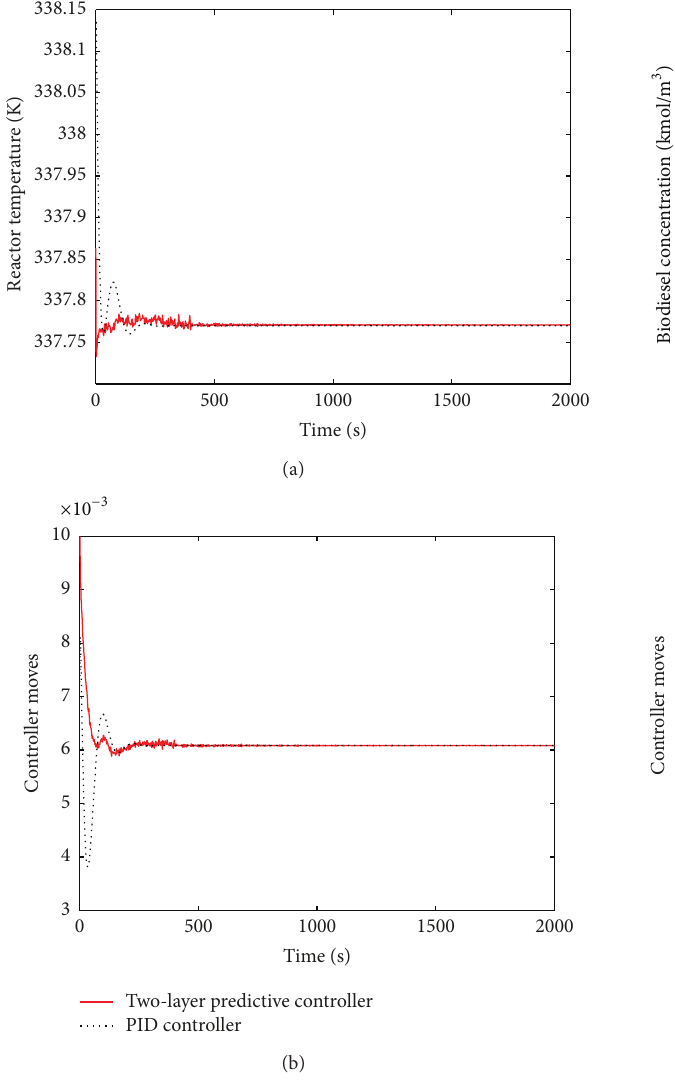
Figure 11: Reactor temperature and controller moves of two-layer predictive controller and PID controller.